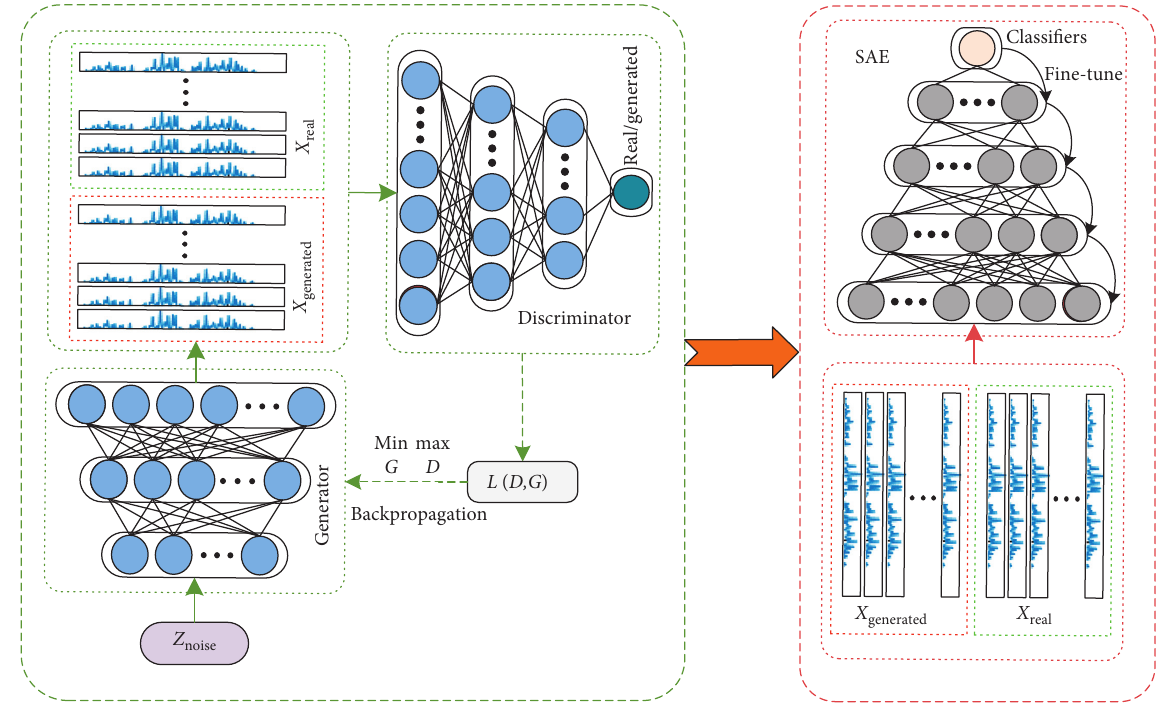
Figure 2: Fault diagnosis model design. Table 1: Description of the unbalanced Datasets A and